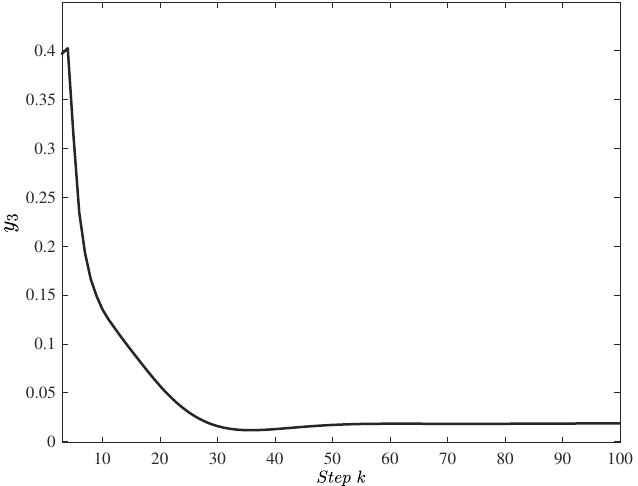
Figure 13. Drum water level